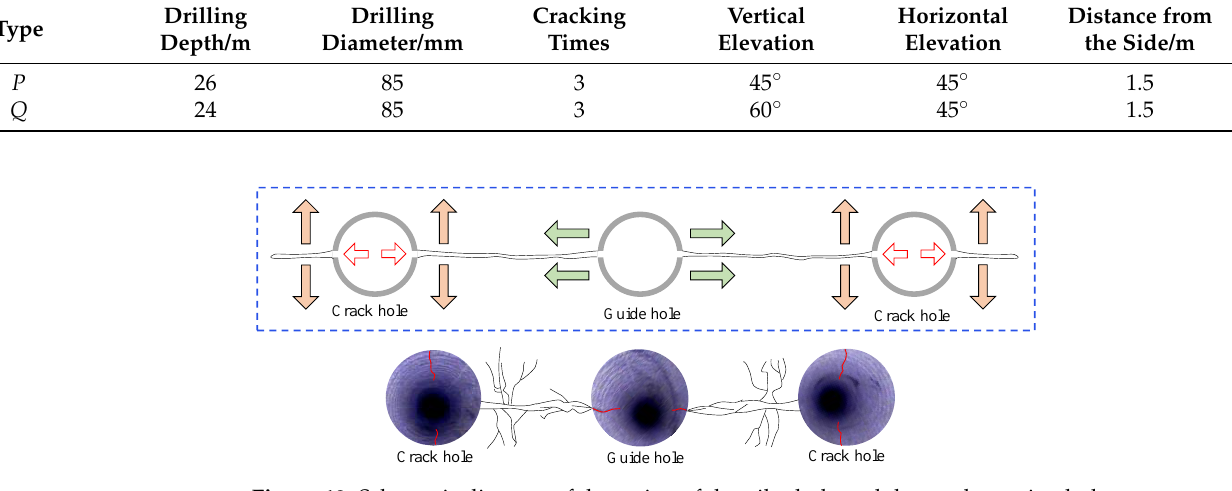
Figure 19. Schematic diagram of the action of the pilot hole and the crack-causing hole. Table 3. Specific parameters of hydraulic fracturing drilling.